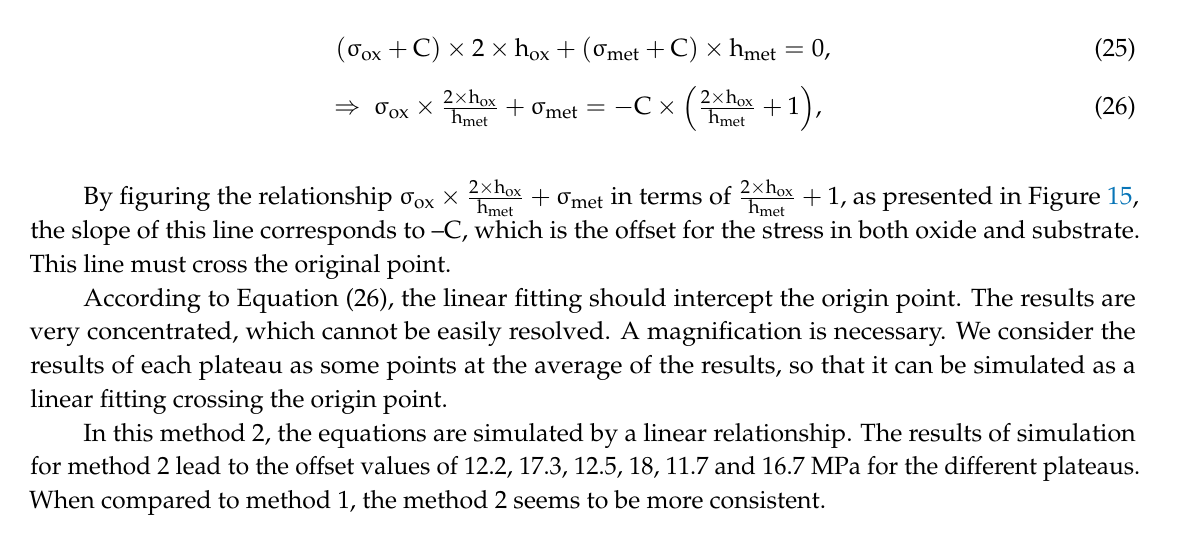
+ σ met as a function of 2 × h ox h met ×  + σ  as a function of